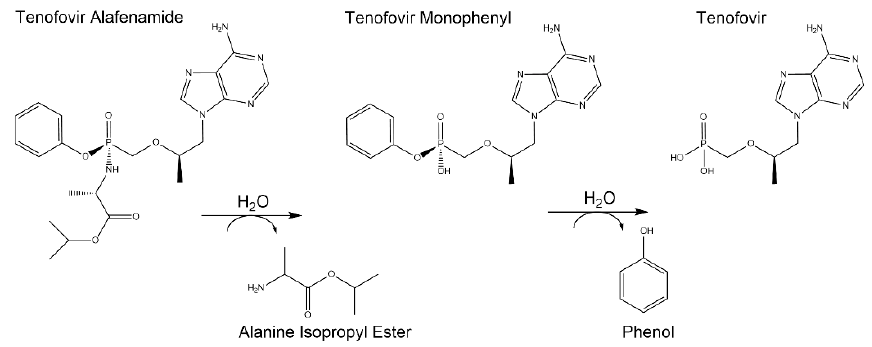
Figure 7. Postulated predominant TAF degradation pathway inside the implant reservoir.